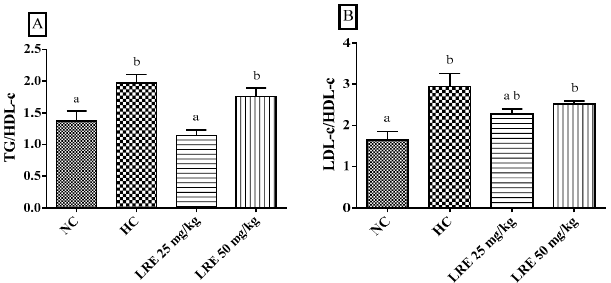
Figure 3. Atherogenic indexes of TG/HDL-c ( A ) and LDL-c/HDL-c ratios ( B ) of hamsters submitted to experimentally induced dyslipidemia and treated with LRE. Each column represents mean ± SEM (standard error of the mean) of 7-9 animals/group. Two mean values that are not indicated with the same letter are significantly different from each other ( p < 0.05). One-way ANOVA followed by Tukey’s test.